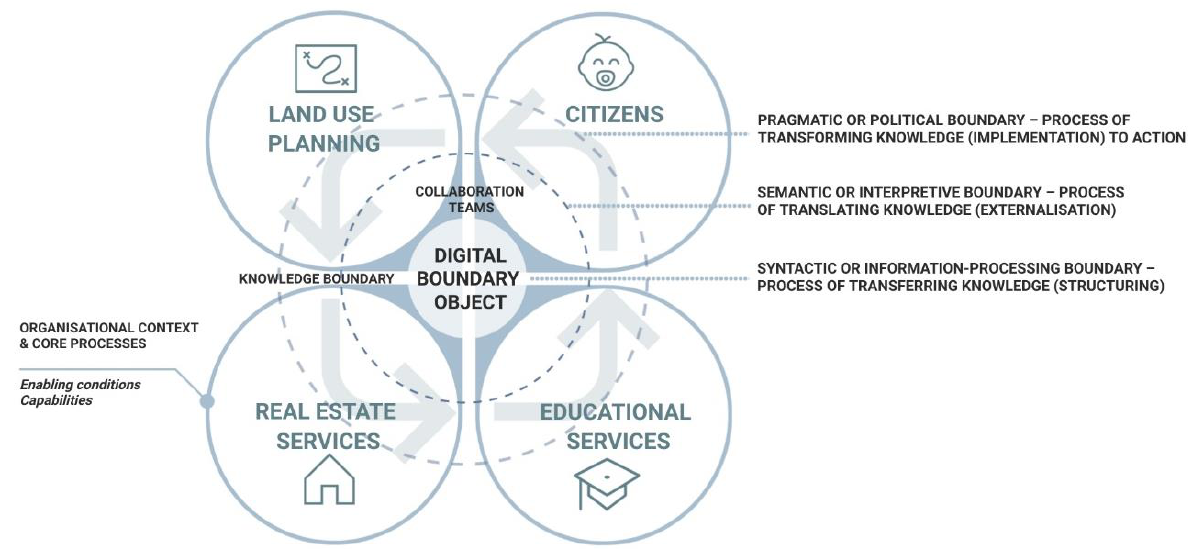
Figure 1. The concept of a digital boundary tool for dynamic service network planning. Transferring, translating and transforming knowledge [51] through an intelligent planning and decision-making platform.